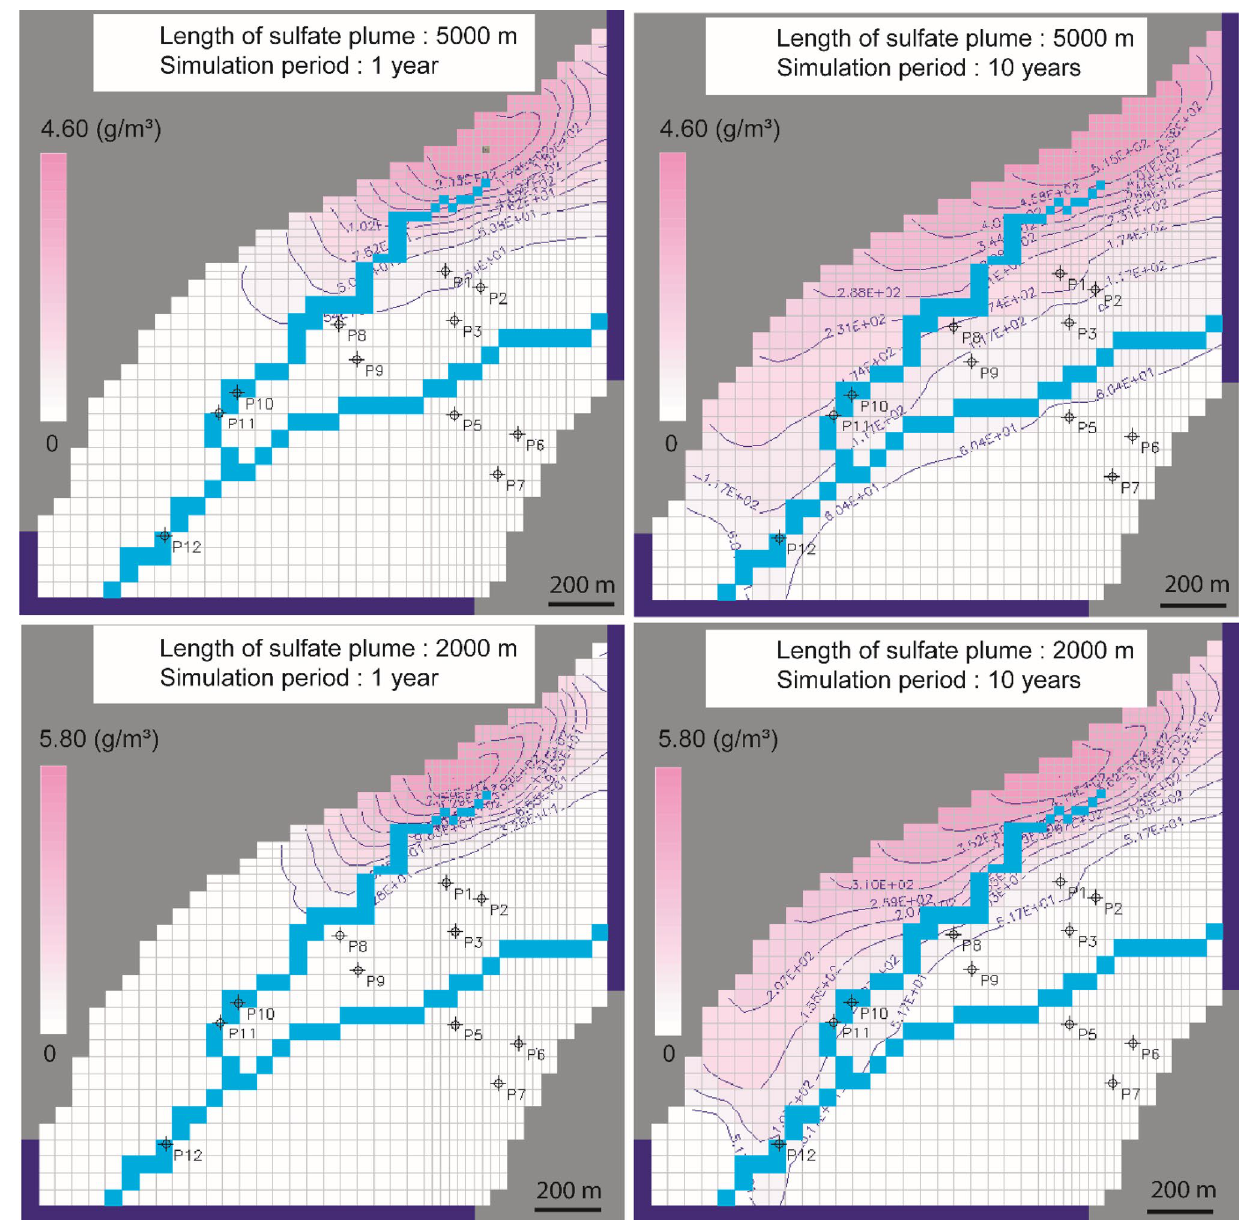
Fig.9 Sulfate plume simulation assuming under remediation condition of scenarios 1 and